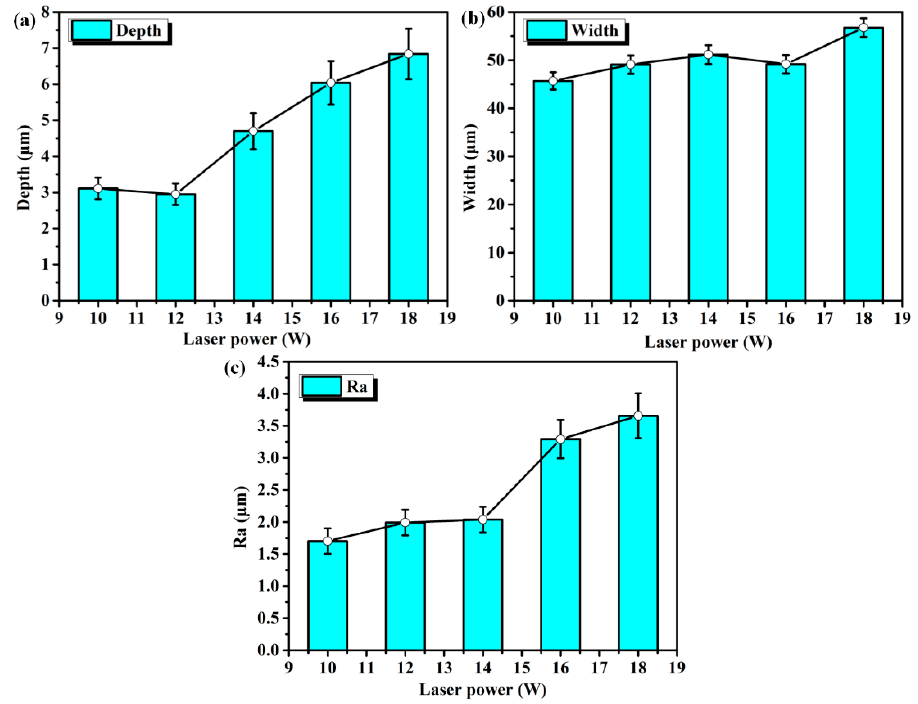
Figure 5. The width, depth, and Ra of microdimple structures under different laser average powers. ( a ) The influence of laser power on dimple depth. ( b ) The influence of laser power on dimple width. ( c ) The influence of laser power on surface roughness Ra .